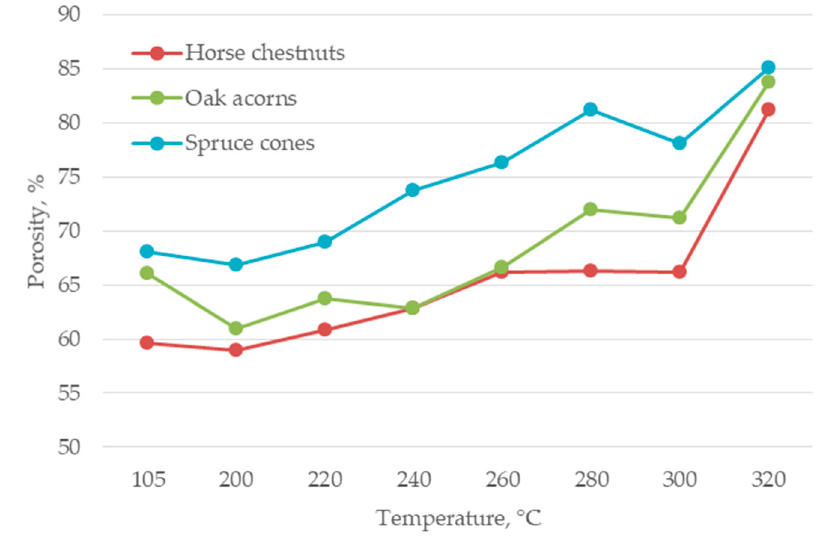
Figure 13. Porosity of the raw and torrefied forestry biomass.